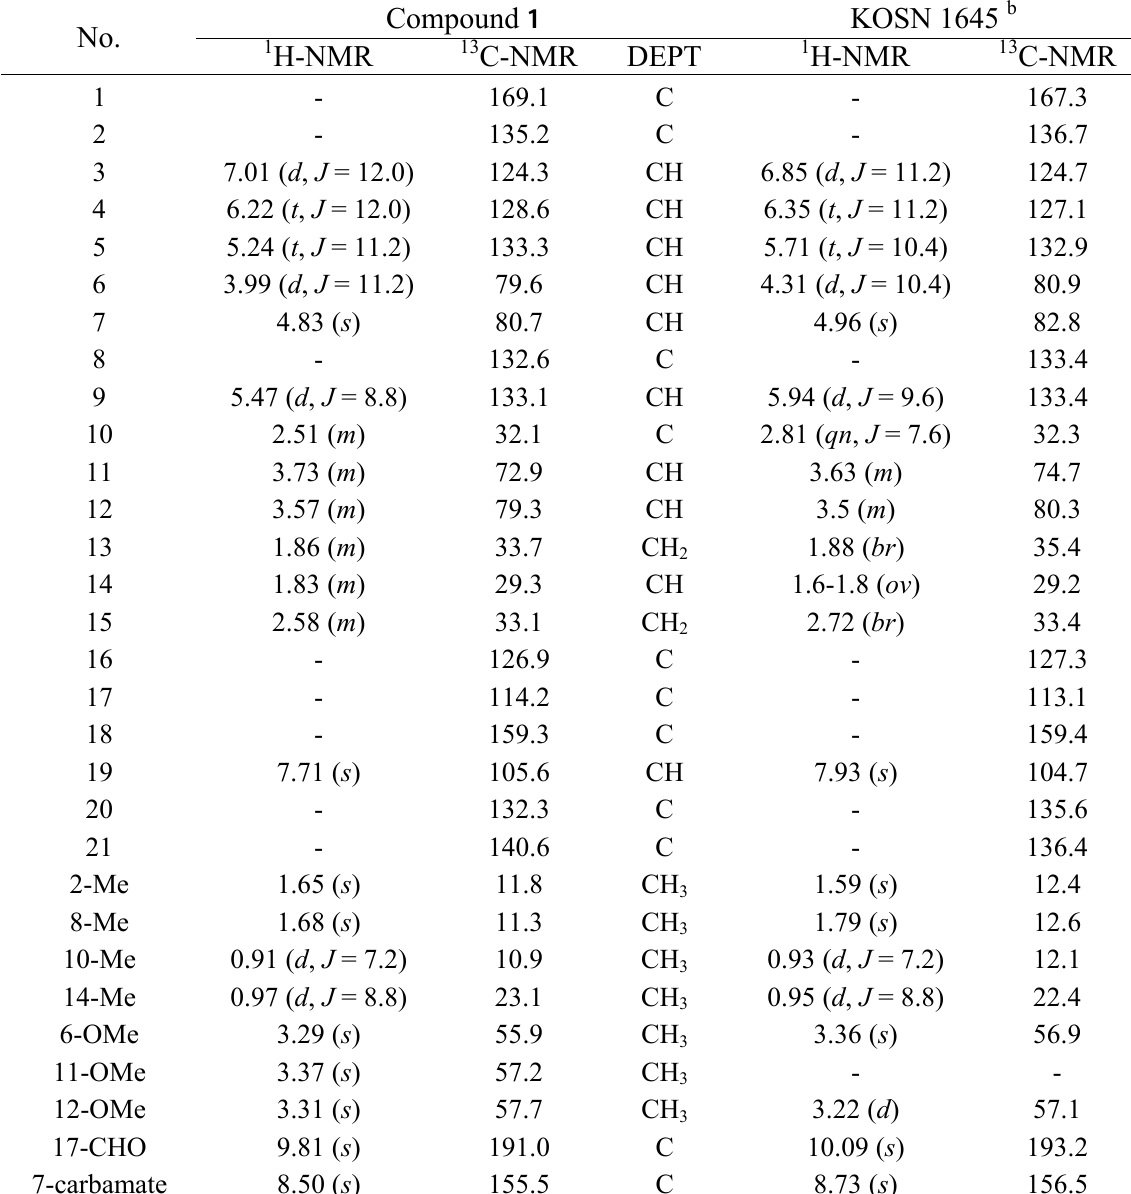
Table 1. The NMR data of compound 1 .